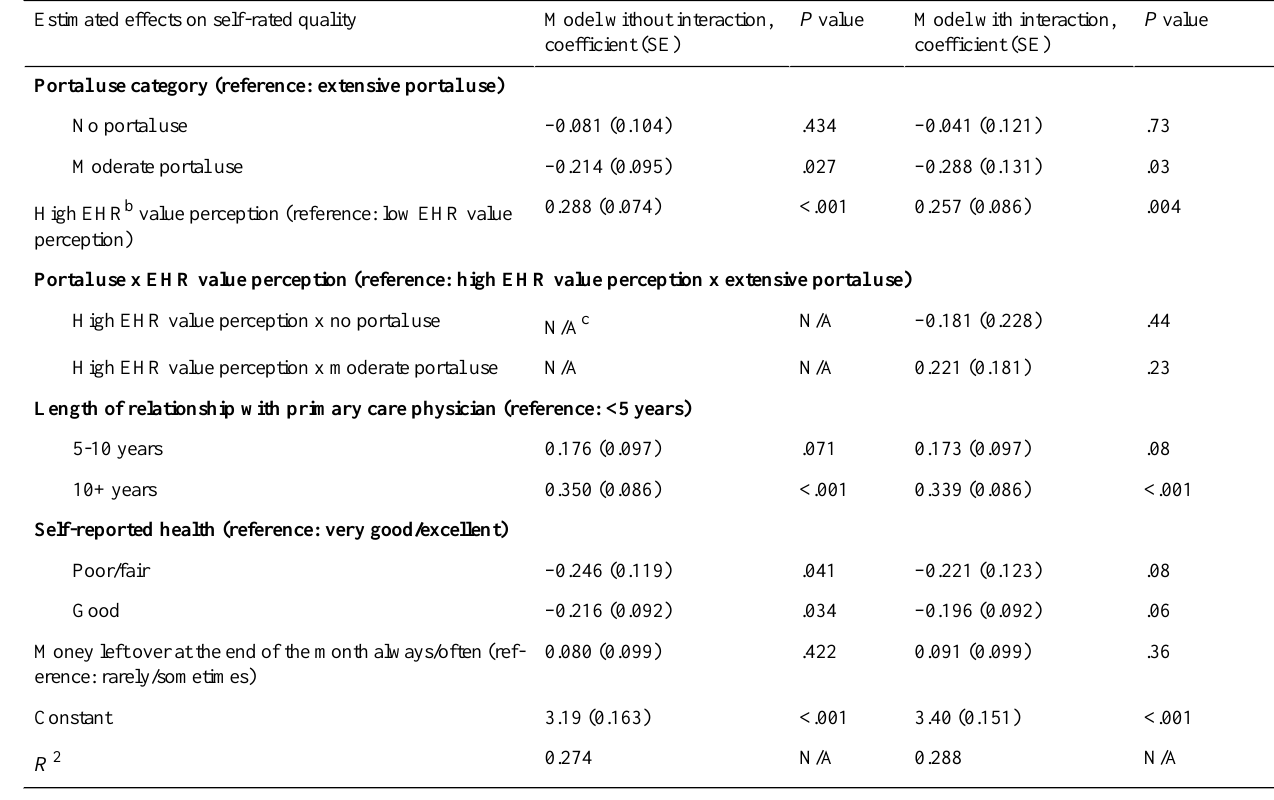
Table 2. Multivariate ordinary least squares regression results: adjusted estimated effects on overall patient self-rated quality (N=158). a